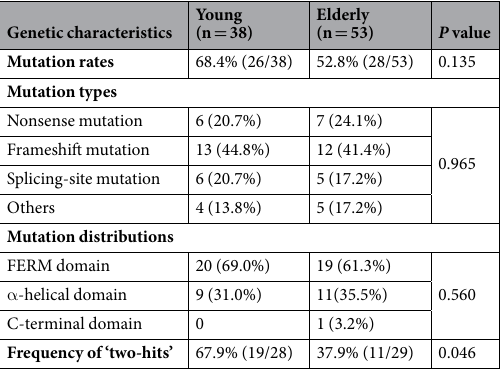
Table 2. Comparisons of genetic characteristics between young and elderly sporadic